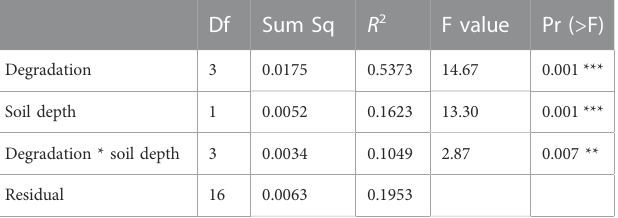
TABLE 1 Two-way PerMANOVA of degradation severity and soil depth on composition of CAZyme gene families. Df: degree of freedom; Sum Sq: sum of